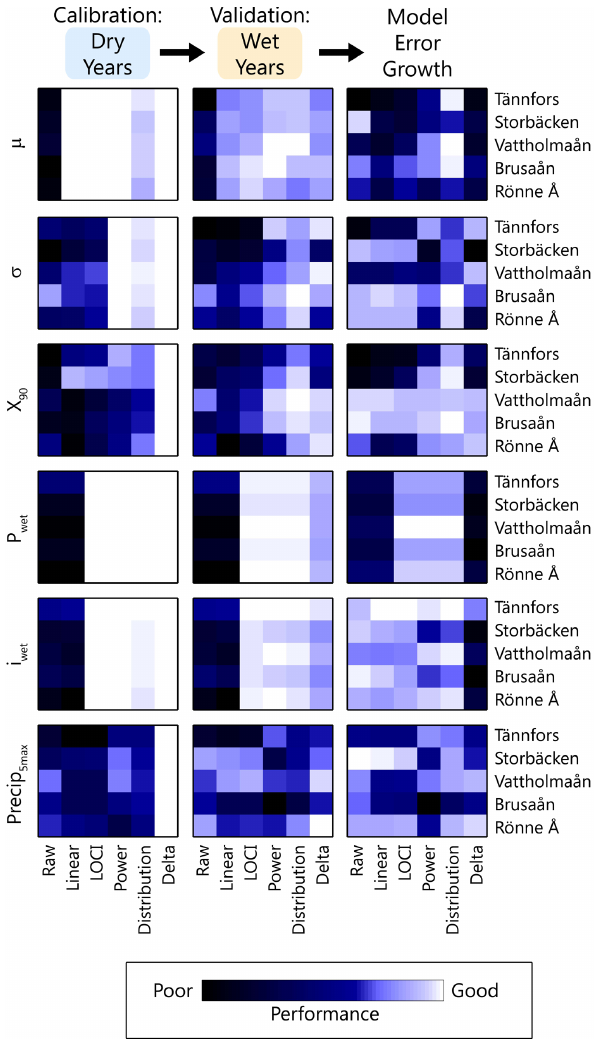
Fig. 6. Normalized precipitation model errors (different shades of blue) of 6 different statistical diagnostics (panel rows) for calibra- tion period (left panel column) and validation period (central panel column). The model error growth, i.e., the absolute difference be- tween model errors in validation and calibration period, is shown as well (right panel column). Each panel displays model error in- formation depending on the 6 applied bias correction methods ( x axis) and the 5 catchment locations ( y axis). The figure is based on case-2 evaluation with calibration on wet years and validation on dry